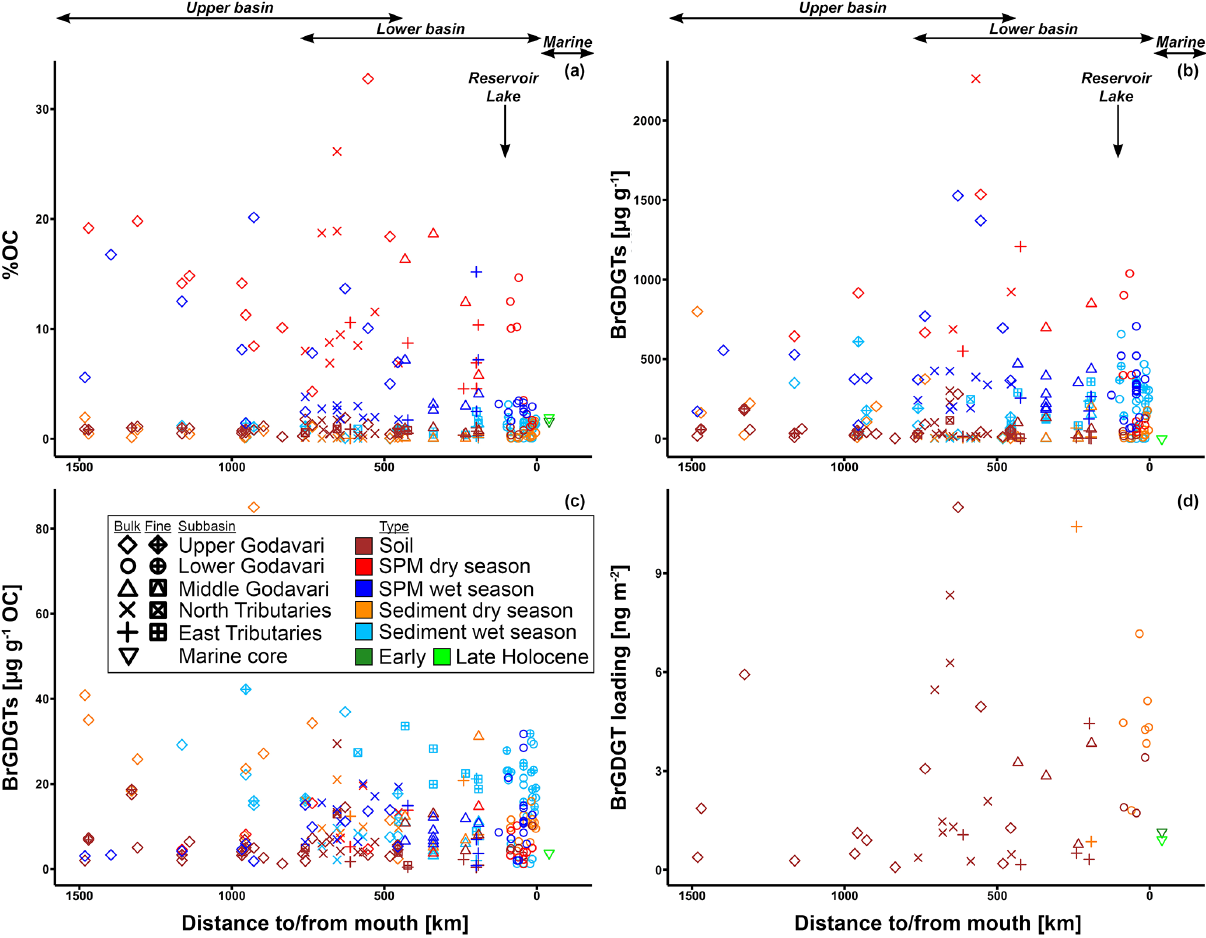
Figure A3. Evolution of %OC and brGDGTs along the Godavari River. (a) %OC; (b) brGDGT concentration normalised to sediment weight; (c) brGDGT concentration normalised to OC versus distance to/from the river mouth for soils, SPM, and riverbed sediments and average values for Holocene sediments in the marine realm (error bars ( ± SE) are too small to be visible); and (d) brGDGT loadings, i.e. normalised to mineral surface area (MSA; see Usman et al., 2018) for Godavari soils ( n = 46), riverbed sediments collected in the dry season ( n = 9), and average values for Holocene sediments in the marine realm ( n = 46; error bars ( ± SE) are too small to be visible). The upper basin is defined as the upper Godavari and two sites (42 and 43, at 655 and 759km from the mouth, respectively) in the north tributaries. The lower basin comprises the other north tributary sites, the east tributaries, and the middle and lower Godavari. The vertical arrow represents the location of the reservoir dam at Rajahmundry. The symbols refer to the different subbasins and the different fractions (bulk and fine fractions ≤ 63µm). The colours refer to the different sample